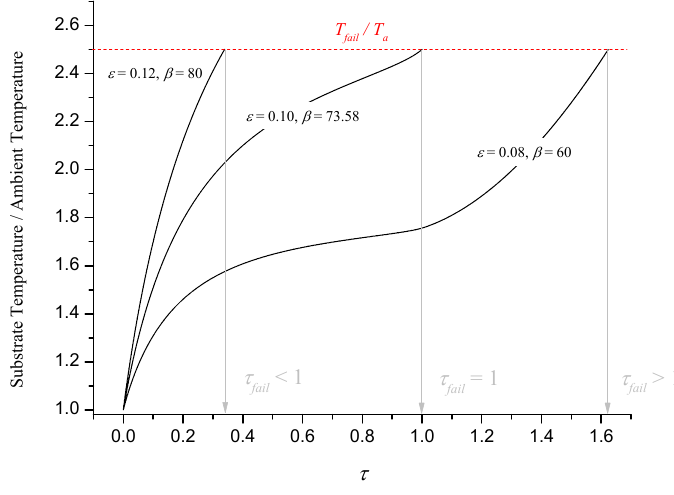
Figure 11. Illustration of numerical results for substrate